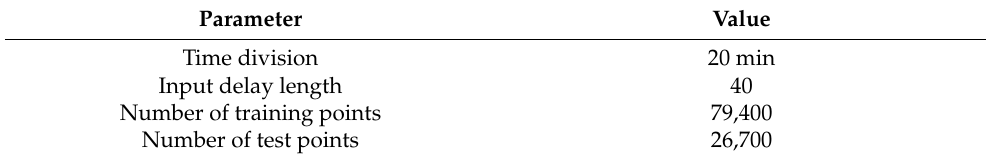
Table 7. The 1st network configuration values (when evaluating the impact of number of hidden layers). Parameter Value Time division